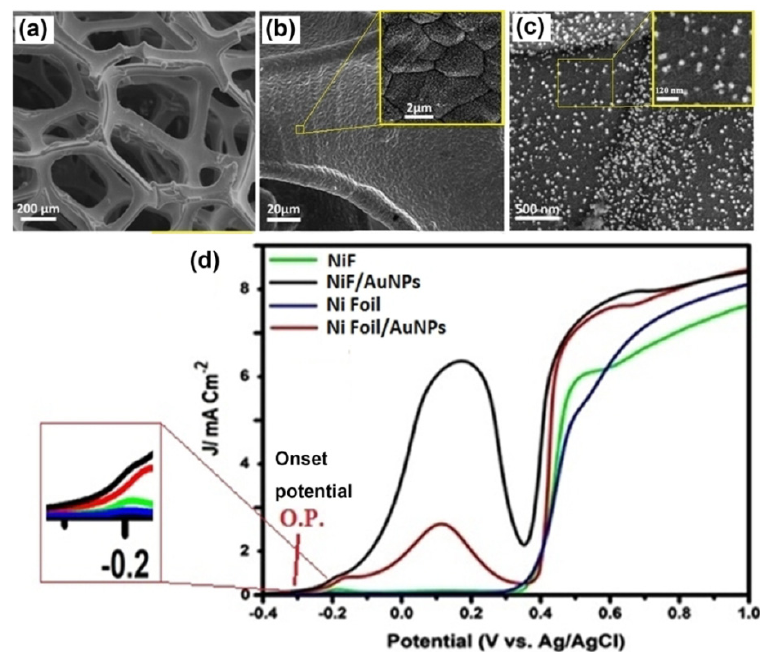
Figure 9. SEM images of (a) 3D Ni foam, and (b,c) 3D Ni foam decorated with Au nanoparticles. ( a ) The typical open-pore cellular structure of Ni foam. ( b ) The strut structure consists of equalized grains with an average size of ~10 µ m. ( c ) Further zoom-in image shows the strut surface decorated with Au nanoparticles by the electrochemical deposition method. The inset demonstrates the uniformly and separately distributed spherical Au nanoparticles. ( d ) Linear sweep voltammetry of electro-catalytic activity of Ni-based electrodes in 0.5 M NaOH solution containing 1.0 M ethanol. The inset reveals the enlarged view of onset potential. Reproduced with permission from [110] . Copyright 2018, Wiley- VCH.